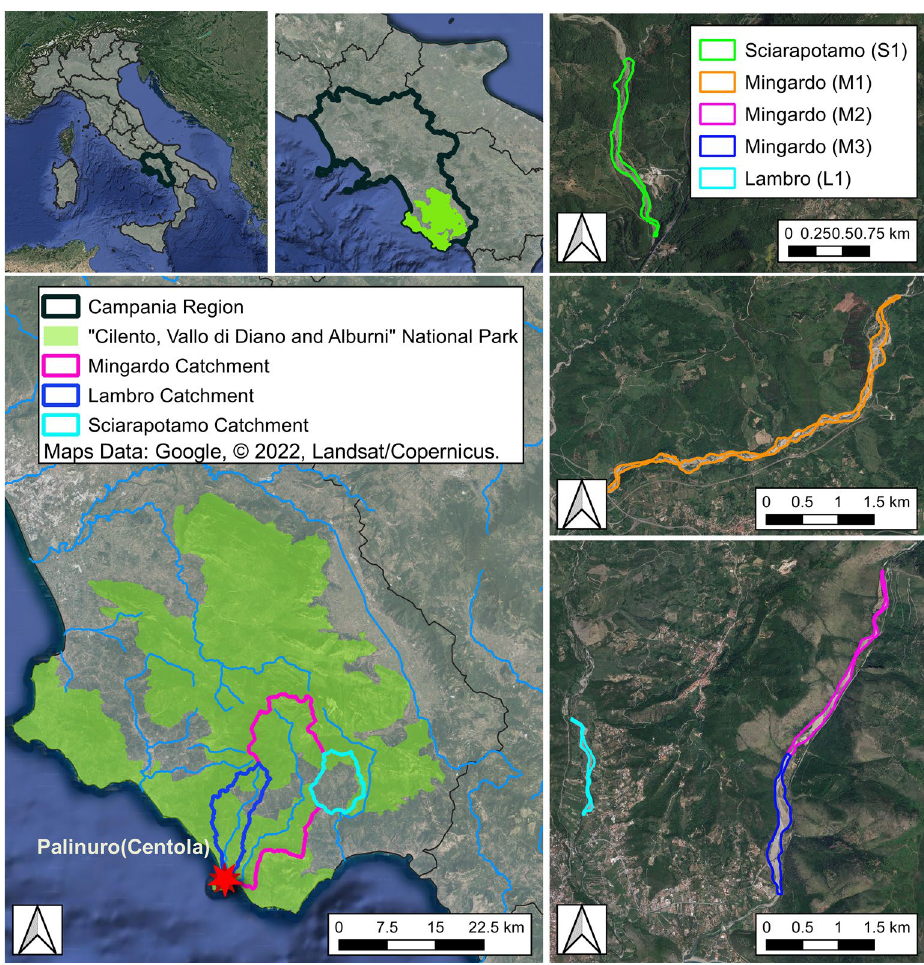
Figure 1. Geographical framework of the study area. Maps Data: Google, © 2022, Landsat/Copernicus. QGIS 3.10.11 https:// www. qgis. org/ it/ site/ forus ers/ downl oad.